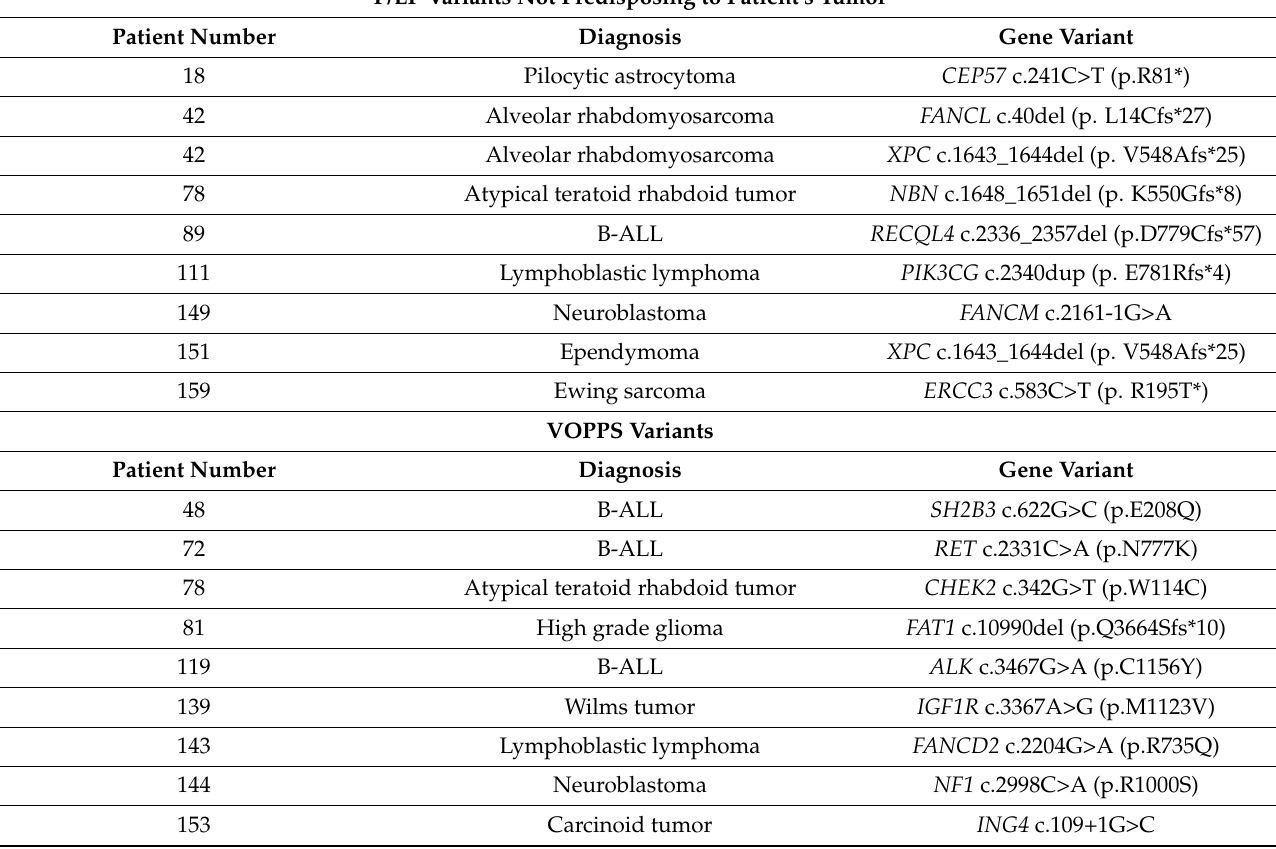
Table 2. Pathogenic or likely pathogenic variants considered as not involved in the tumor etiology by the Pediatric Cancer Predisposition Committee. Variants of uncertain significance to which potential pathogenicity was attributed by the committee (variants of potential pathogenic